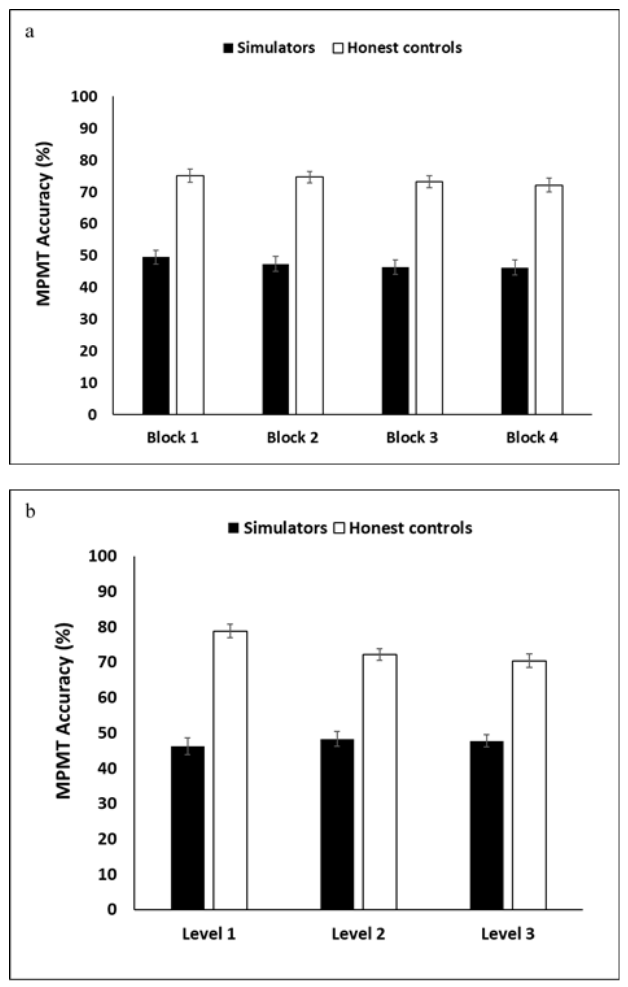
Figure 5. Accuracy scores per group across the four MPMT blocks ( a ) and three levels ( b ). An analysis of participants’ perceived cognitive load revealed significant block and level main-effects ( F (3,225) = 6.50, p < 0.001, η p ² = 0.08; F (2,150) = 154.43, p < 0.001, η p ² = 0.67; respectively); participants reported experiencing more cognitive load as they progressed through the MPMT. The only significant interaction was between block and level ( F (6,450) = 2.41, p = 0. 026, η p ² = 0.03). The group main effect was not significant ( p = 0.189); see Figure 6.